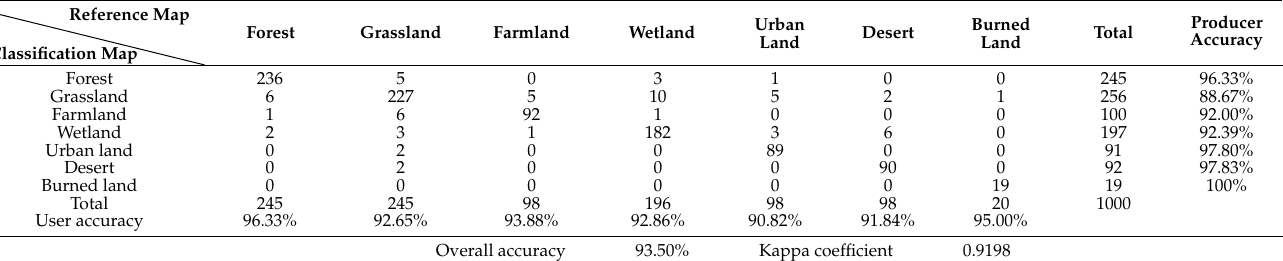
Table A1. Error matrix of land cover classification in 2000.